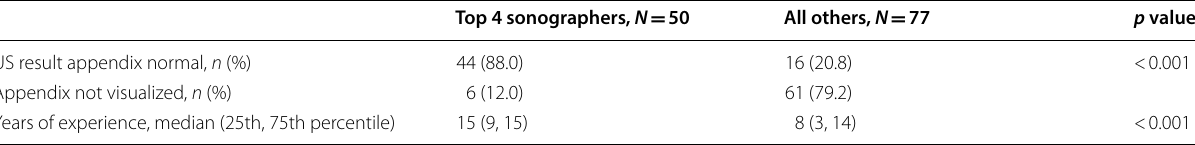
The p value is based on the Pearson Chi-square test and the Mann–Whitney U